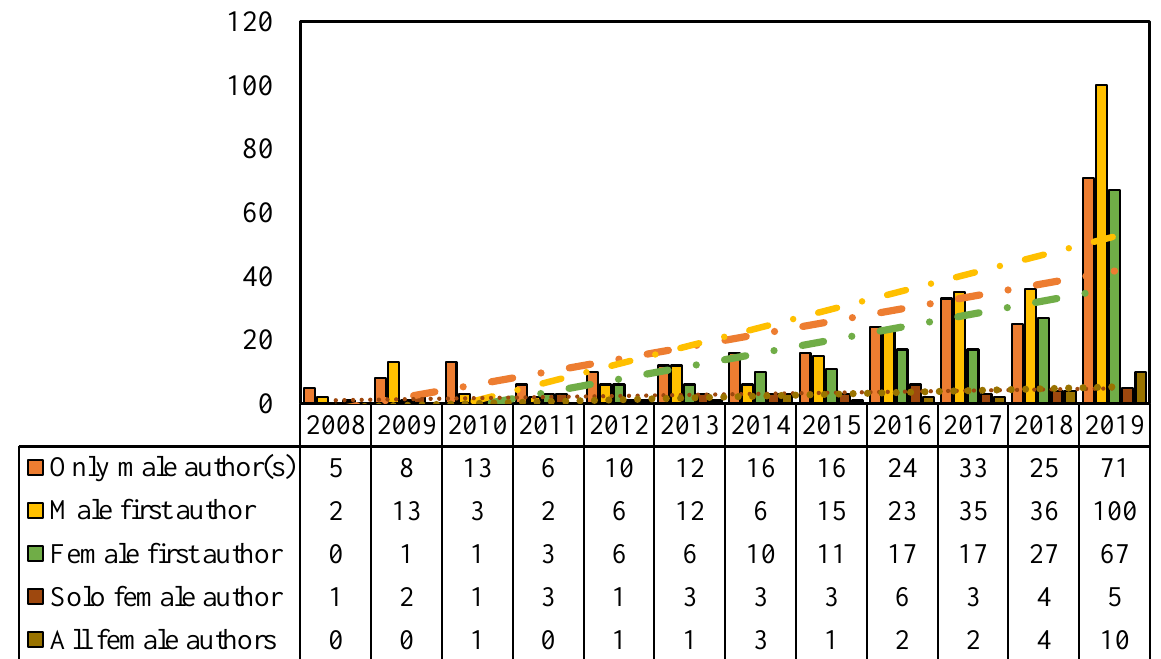
Figure 3. The annual Gold Access publications by the gender-based authorship structures.